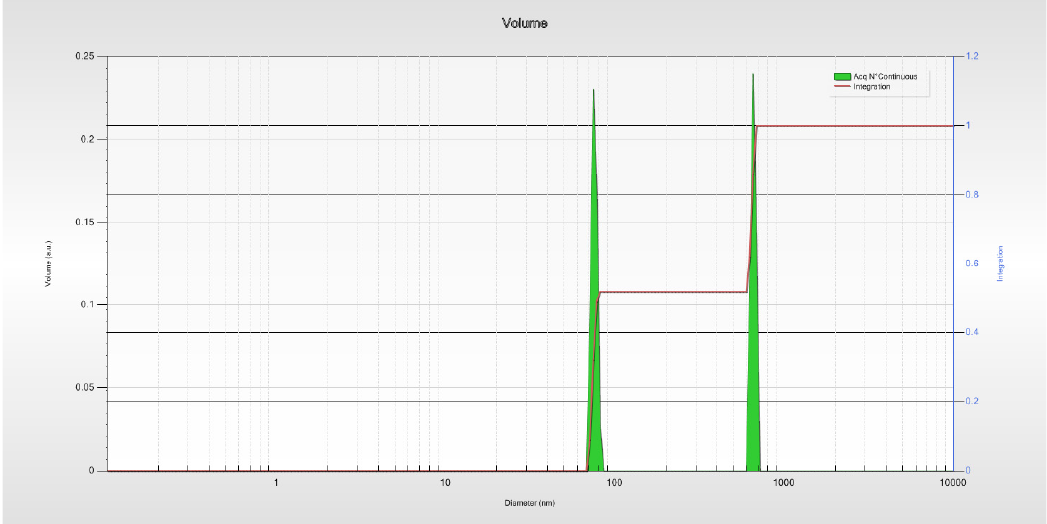
Fig. 4. Particle size distribution of MIPs measured by dynamic light